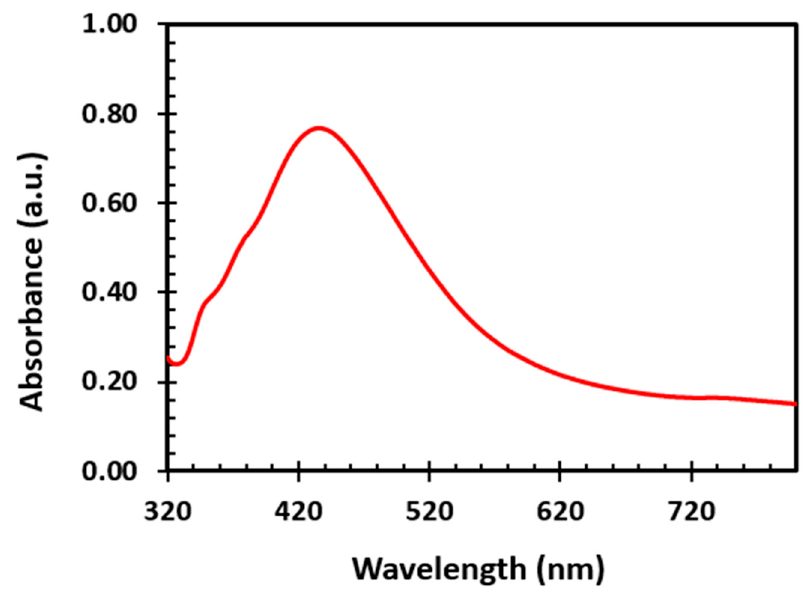
Figure 1. Absorption Spectra of Silver Nanoparticles (AgNPs) showing the SPR band.